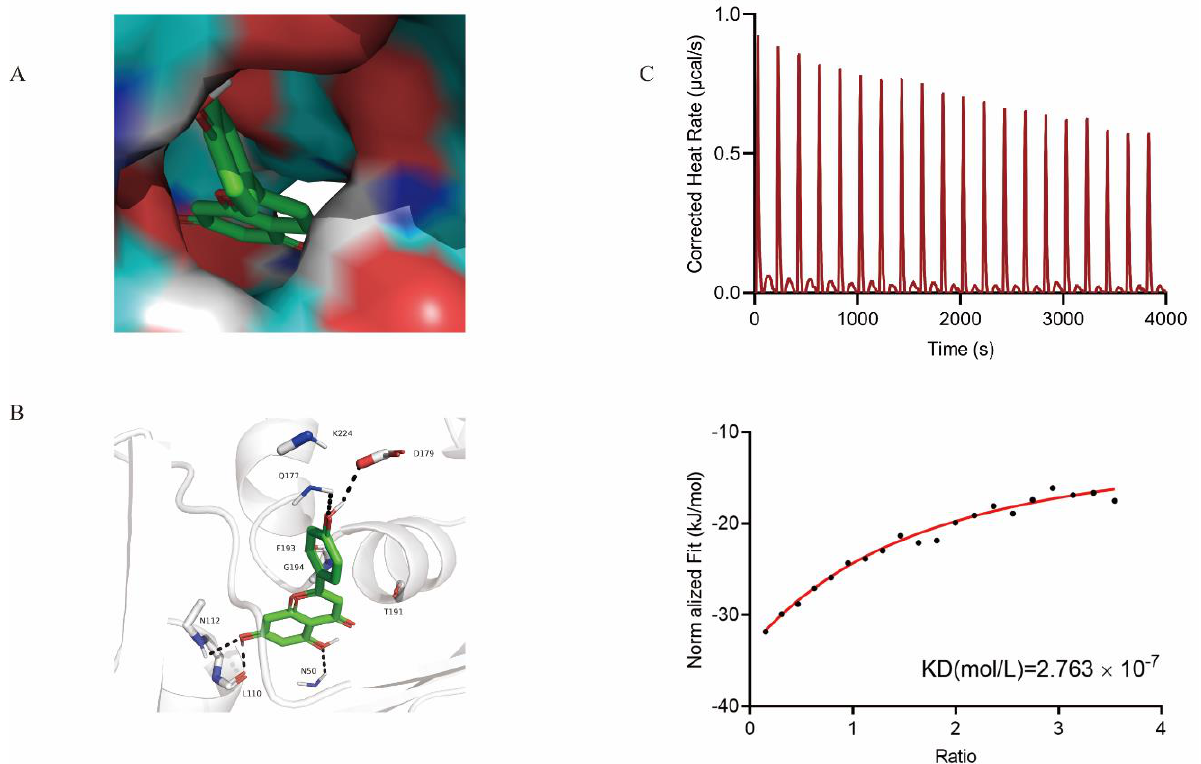
Figure 4. Based on the directly binding to the suilysin (SLY), apigenin could destroy hemolytic activity. ( A ) Apigenin was docked into the binding site of the SLY (Total view). ( B ) Apigenin and SLY binding site. (Detailed view). The apigenin was represented with green sticks. The hydrogen bond was shown in a black dotted line. ( C ) Isothermal titration calorimetry (ITC) was used to analyze the interaction between SLY and apigenin. 0.2 mmol/L of apigenin was dropped into 0.02mmol/L of SLY in PBS buffer at 25 ◦ C. Thermodynamic parameters were calculated, including the equilibrium dissociation constant (KD = 2.763 × 10 − 7 mol/ L).